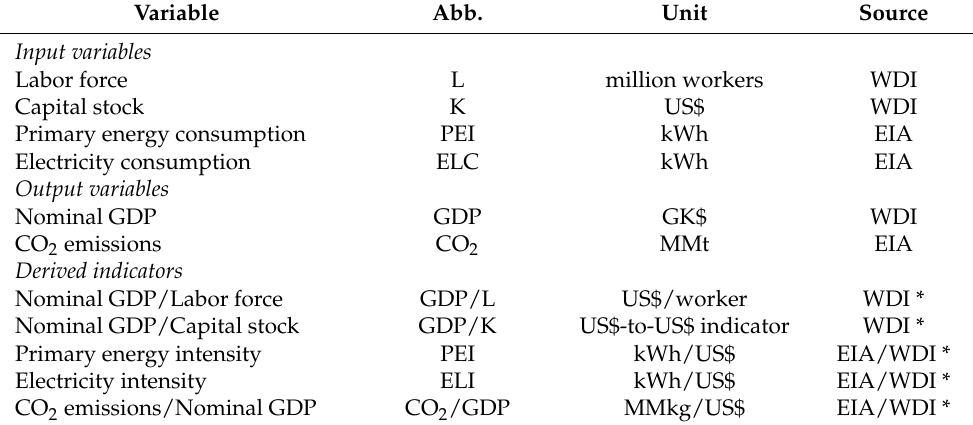
Table A2. Definition of